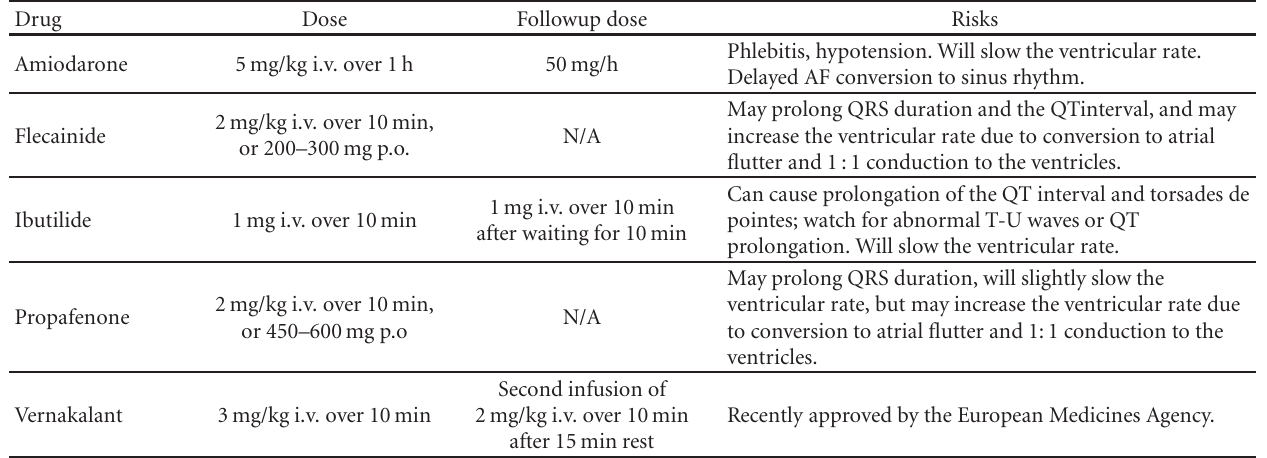
Table 1: Acute rhythm